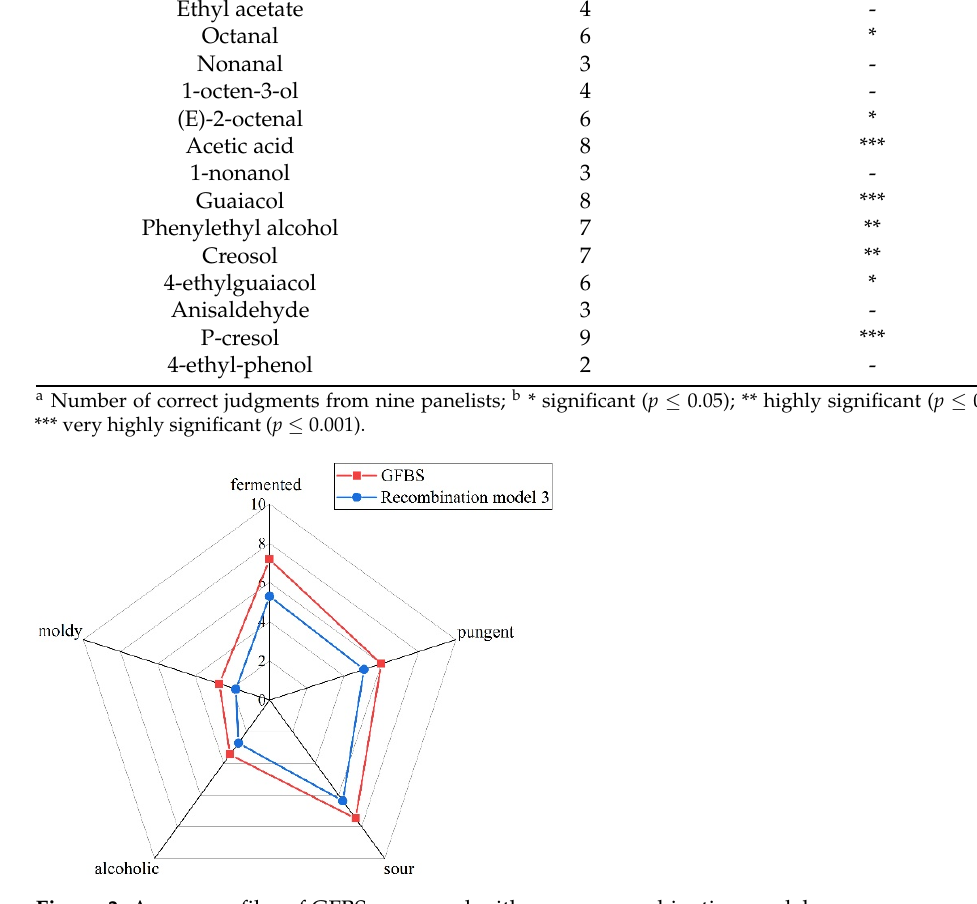
Figure 3. Aroma profiles of GFBS compared with aroma recombination model.